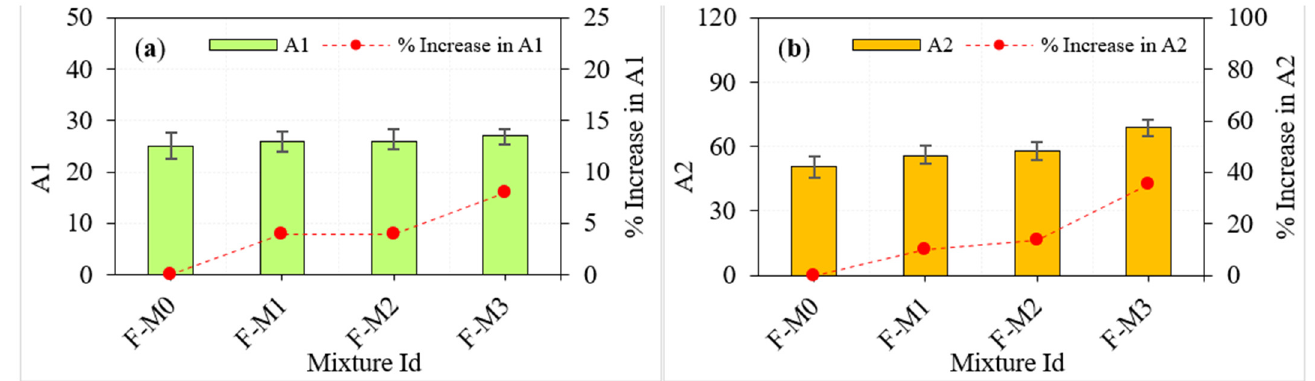
Figure 6. Impact test results of fibrous specimens. ( a ) A1 ( b ) A2.